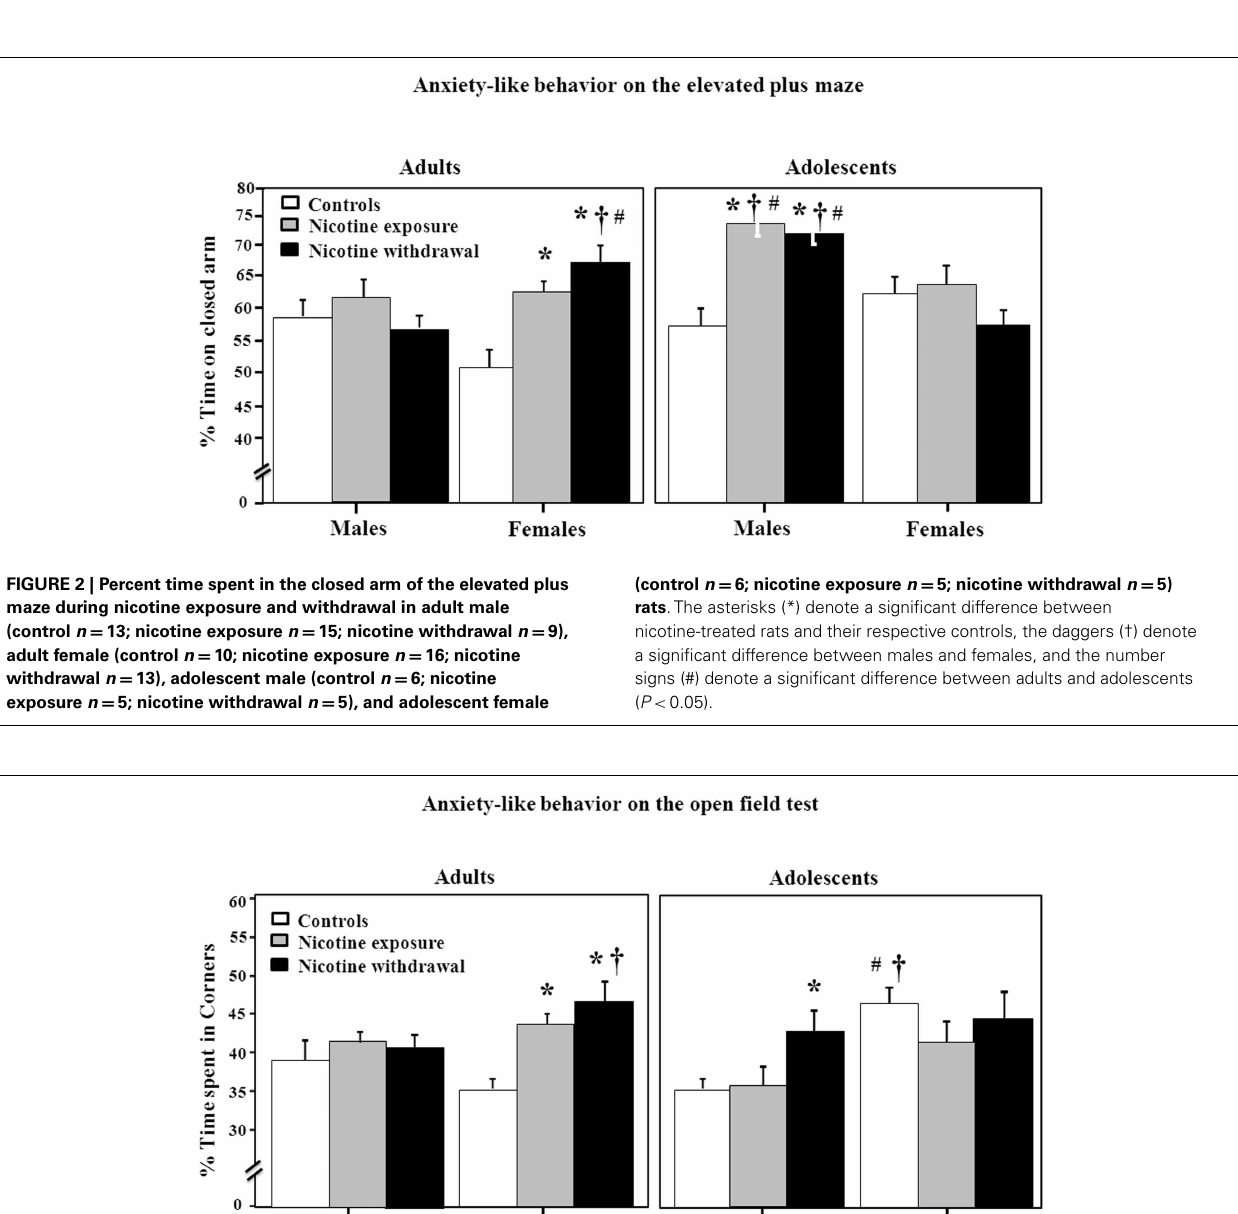
adolescent female (control n = 5; nicotine exposure n = 5; nicotine withdrawal n = 5) rats .The asterisks (*) denote a significant difference between nicotine-treated rats and their respective controls, the daggers (†) denote a significant difference between males and females, and the number sign (#) denotes a significant difference between adults and adolescents ( P < 0.05).